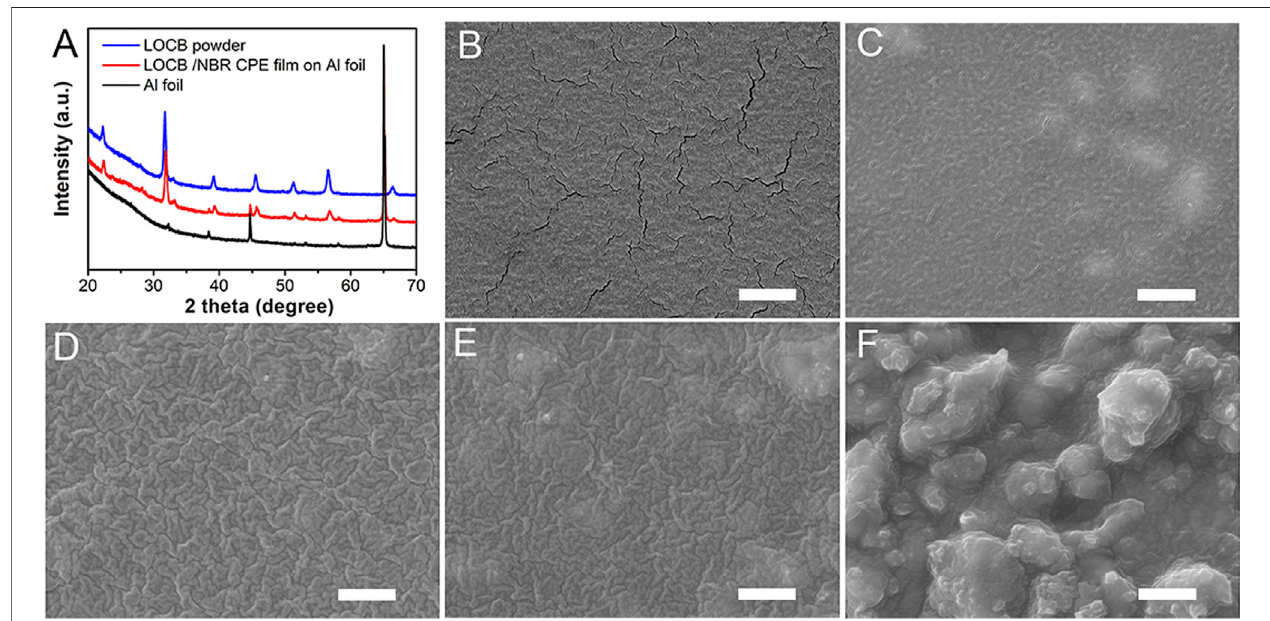
FIGURE 2 | (A) XRD pattern of the pure Li fi lm, and Al foil. (B – F) SEM images of the NBR SPE and Li 2 OHCl 0.5 Br 0.5 , Li 2 OHCl 0.5 Br 0.5 /NBR CPE CPE fi lms with different LiRAP ratios. (B) 0, (C) 20, (D) 40, (E) 60, and (F) 80%. The scale bars are 2